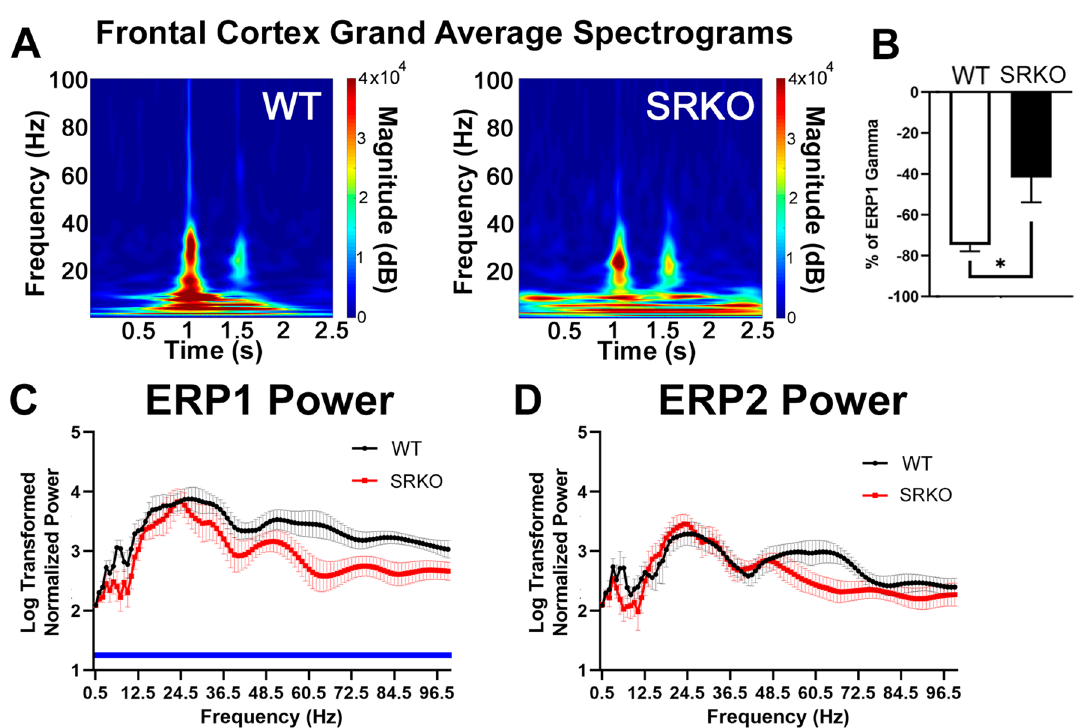
Figure 4. Power Spectral Density Abnormalities Occur in SRKO mice During Sensory Gating. We examined whether there was a sensory gating deficit in evoked gamma power (30–80 Hz). The frontal cortex grand average spectrogram (A) demonstrates the change in evoked power during S1 (1–1.05 s) and S2 (1.5–1.55 s) for WT ( left ) and SRKO ( right ) mice. The frequency comparisons in parts ( B–D ) were calculated using these stimulus times. Similar to ERP amplitude, SRKO mice also demonstrated impaired sensory gating of gamma power (41.7% reduced from S1 to S2) compared to WT littermates (74.8% reduced, B ). To examine task-evoked power spectral density differences between genotypes during each stimulus, the log-transformed normalized power for 0.5–100.5 Hz was analyzed using 1 Hz bins. Compared to WT littermates, SRKO animals had decreased power across the frequency spectrum during ERP1 ( C ) but not during ERP2 ( D ). Stars represent a significant unpaired two-tailed Welch’s t-test. ( C ) had a main effect of genotype in a two-way RM ANOVA, represented by a blue bar under the significantly different